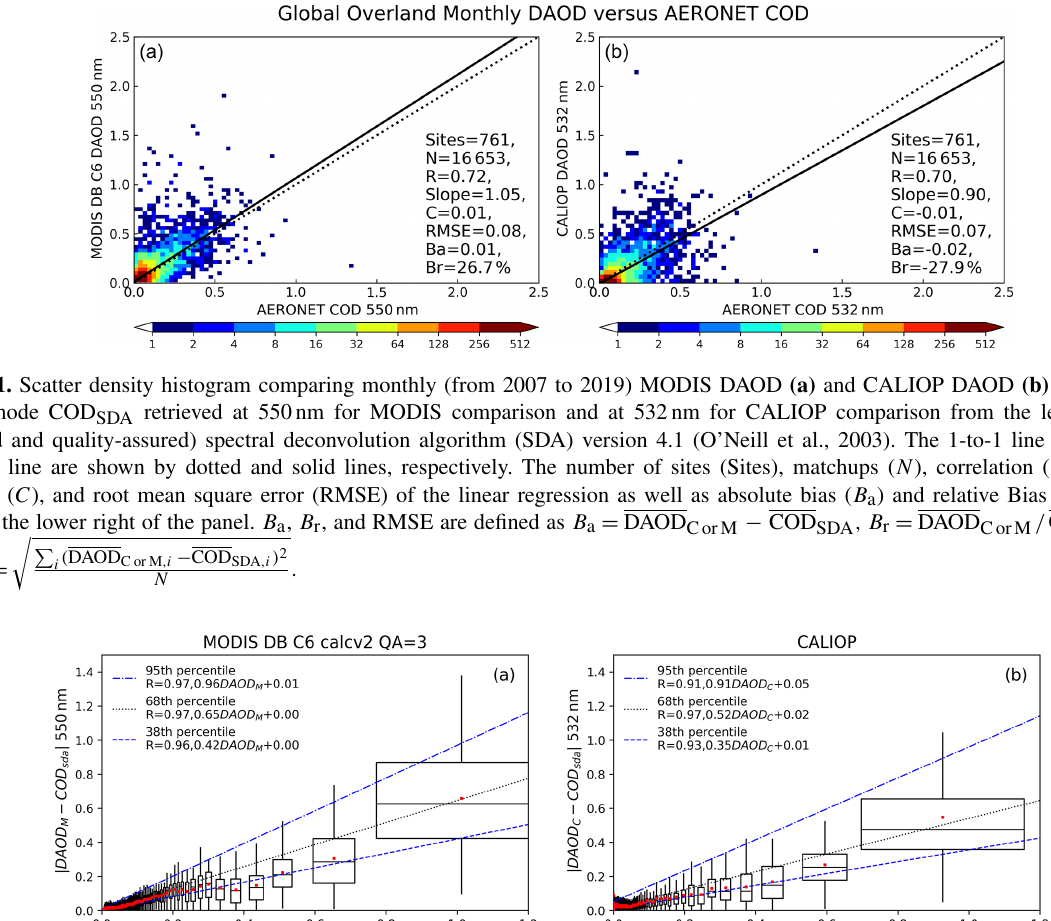
Figure 2. (a) The x axis is the MODIS derived DAOD; the y axis is the absolute MODIS DAOD–AERONET COD difference (without scaling by an geometric air mass factor; AMF). Data are sorted by bins of 100 values (we have 16653 matchups in total; therefore, the last bin has 53 values). The means and standard deviations of the MODIS DAOD M are the centers and half widths of the boxes in the horizontal. The mean, medians, and lower-to-upper quartile interval of the MODIS–AERONET SDA differences are the red dots, the center, and top– bottom intervals of the boxes. The dotted line is the error estimated from the least squares linear fit of the 68th percentiles for each box. Panel (b) is the same except for CALIOP